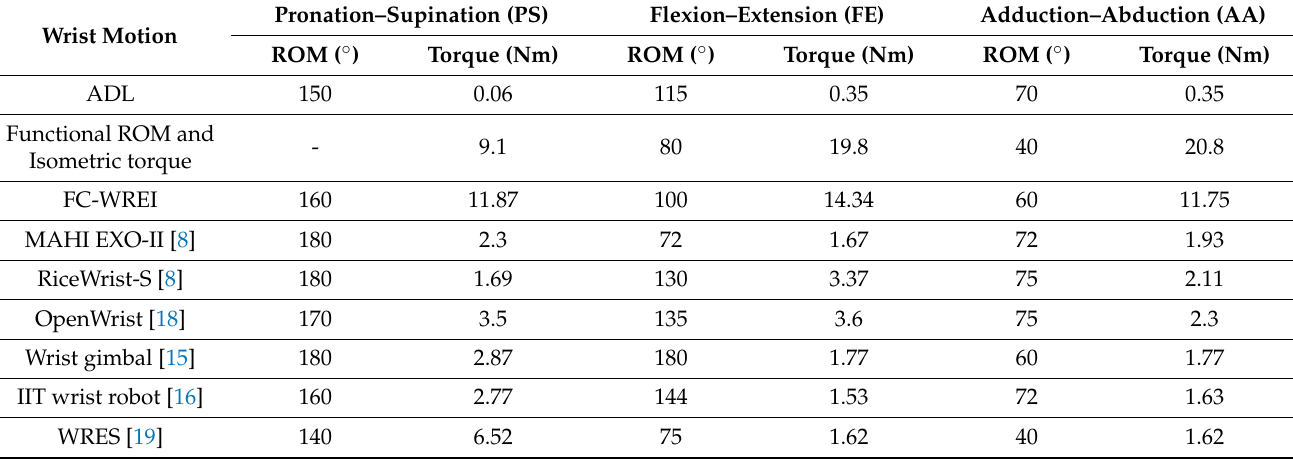
Table 2. Comparison of the ROM and torque capability of similar wrist REIs. The table shows activities of daily living (ADL) and functional ROMs, the isometric torque of the human wrist [8,31,33], and the maximum continuous torque of the wrist